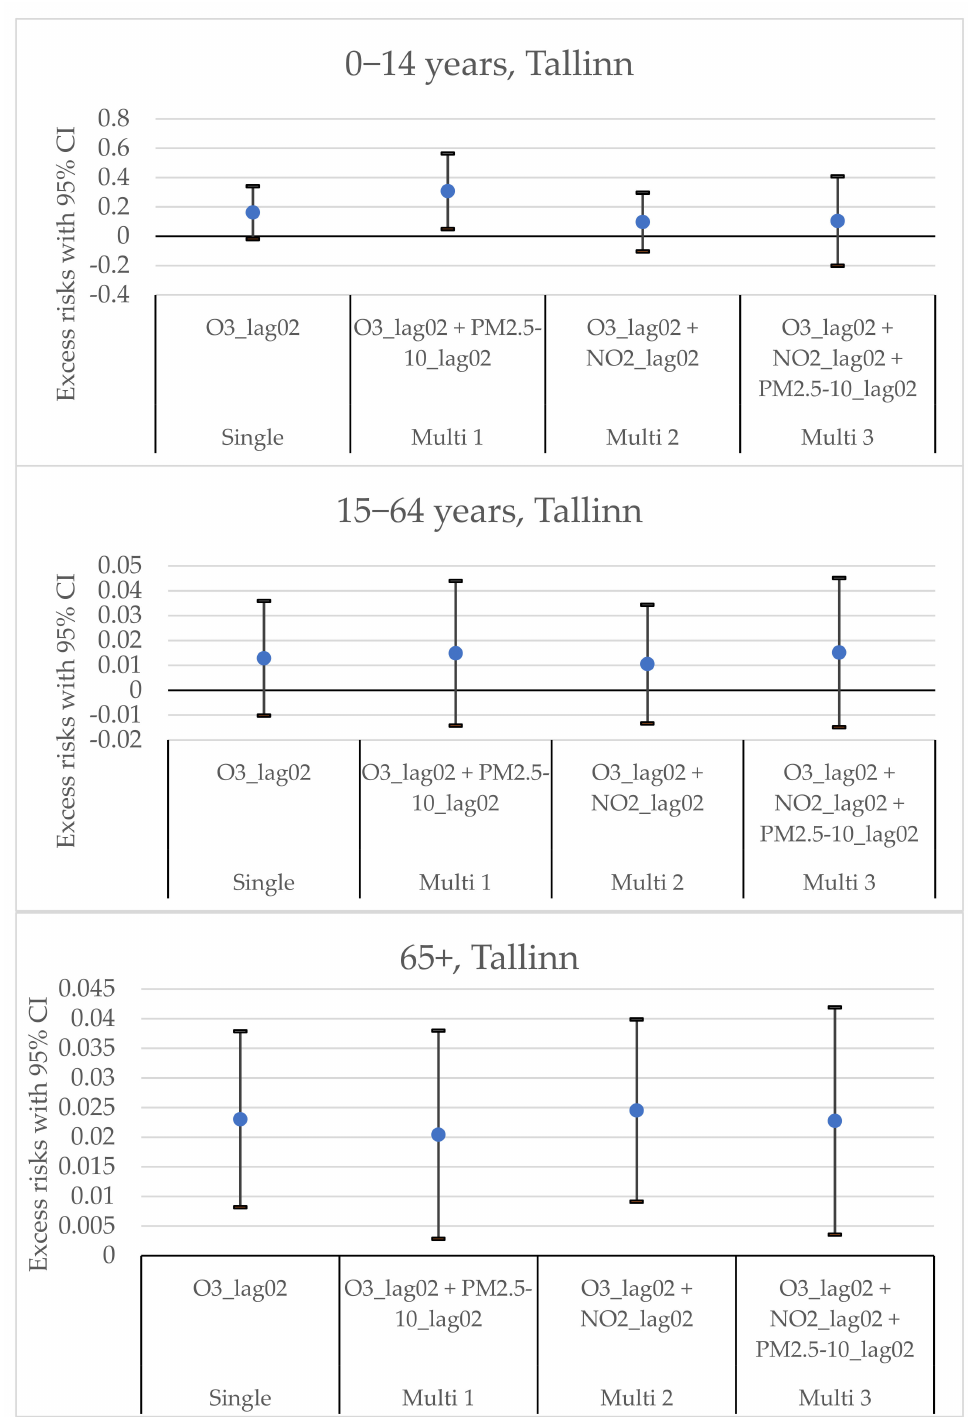
Figure 6. Multi-pollutant models of the estimated change in daily mortality in different age groups (with 95% CI) for an IQR increase in the concentration of O 3 (lag02) in Tallinn. From left to right: a single-pollutant estimate of O 3 (Single), O 3 adjusted for PM 2.5–10 (Multi 1), O 3 adjusted for NO 2 (Multi 2), and O 3 adjusted for both NO 2 and PM 2.5–10 (Multi